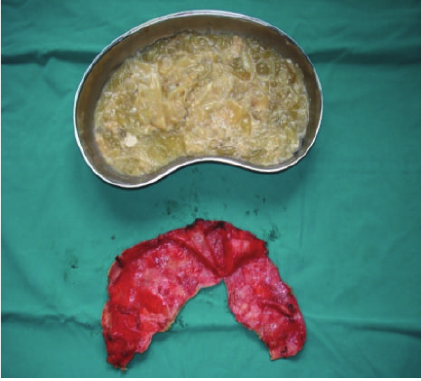
Figure 4: Surgical specimen, content, and walls of the hydatid